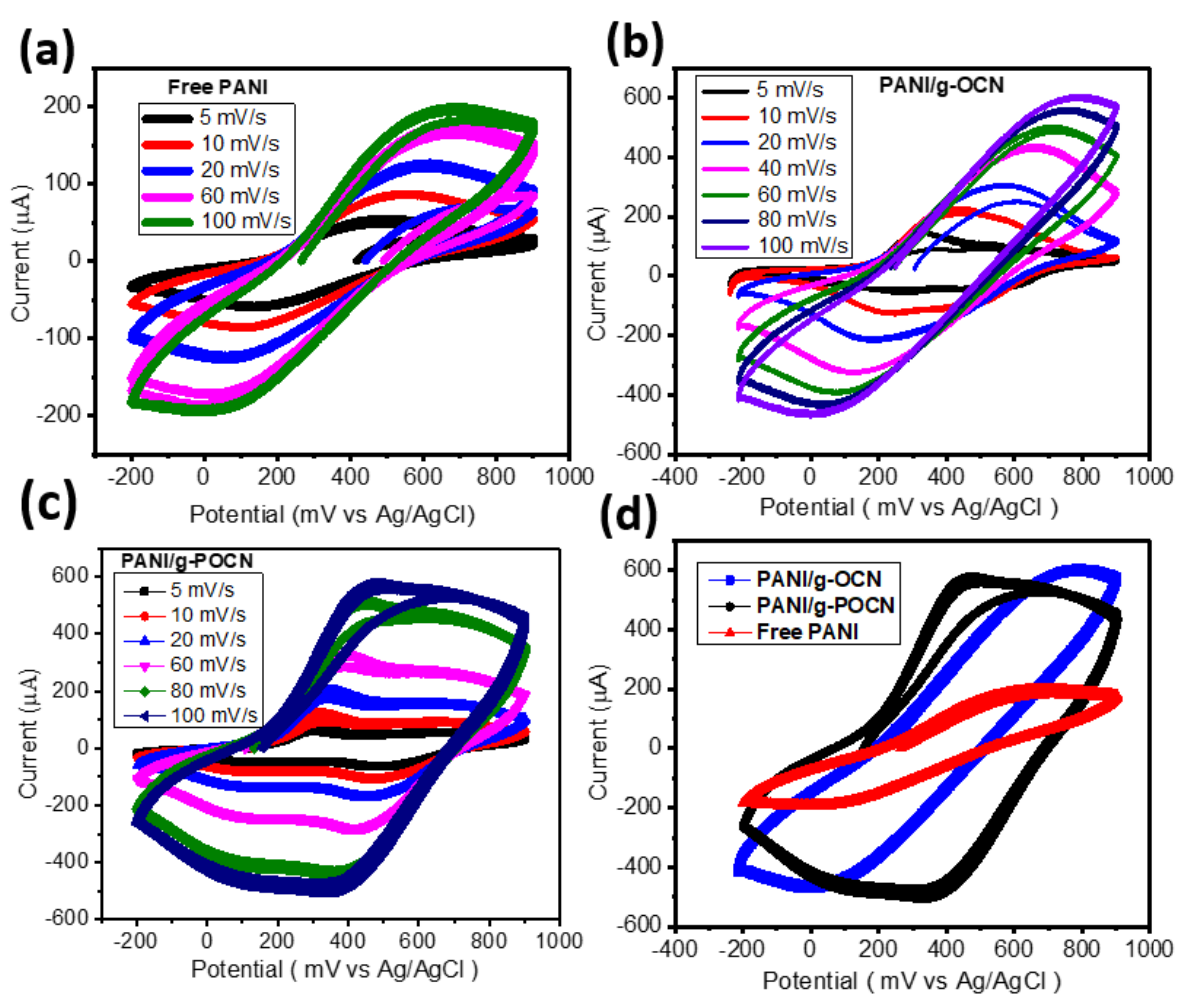
Figure 7. Cyclic voltammetry of the electrodes: ( a ) Free PANI, ( b ) PANI/g-POCN, ( c ) PANI/g-OCN, and ( d ) a comparative plot between the composites.